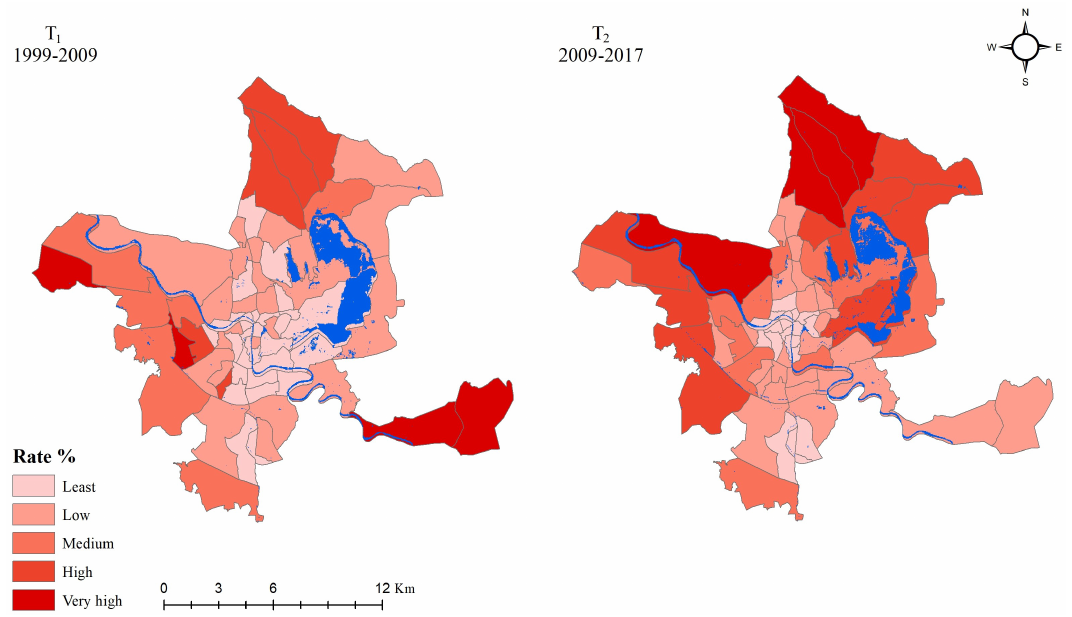
Figure 6. Changes in U er —T 1 and T 2 categorized according to various